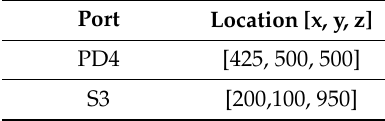
Table 3. Location of the considered sensor and PD source inside the transformer tank, including the transformer winding and metallic